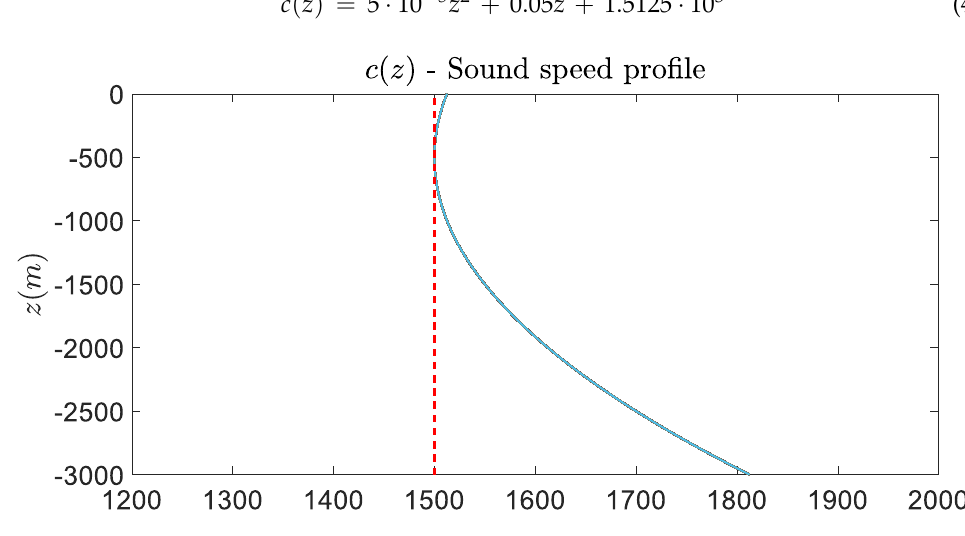
Figure 6. Sound speed profiles.